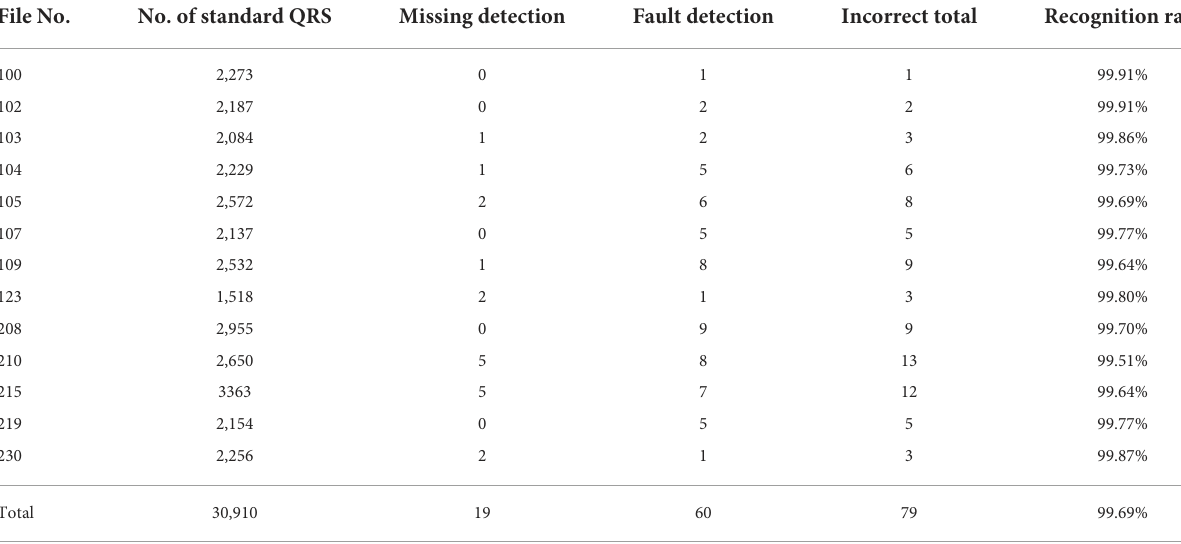
TABLE 2 R-wave detection statistics of partial ECG data in the MIT/BIH database. File No. No. of standard QRS Missing detection Fault detection Incorrect total Recognition